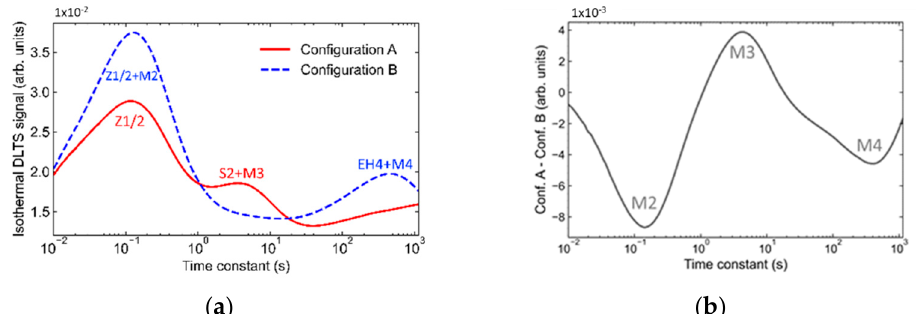
Figure 7. ( a ) Isothermal DLTS spectra for neutron-irradiated 4H-SiC sample with M-center in configurations A (red, solid) and B (blue, dashed) measured at 300 K. ( b ) Different isothermal DLTS signals (configuration A-configuration B).